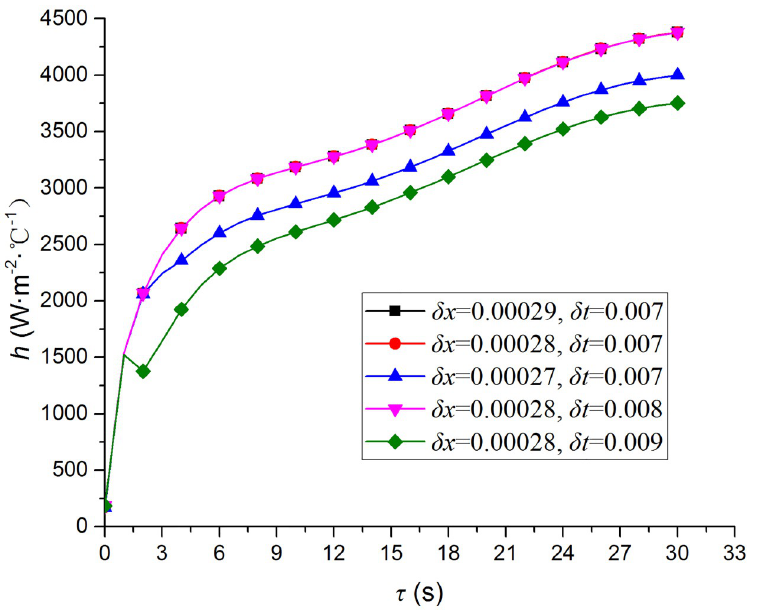
Fig 8. Time step and space step independence